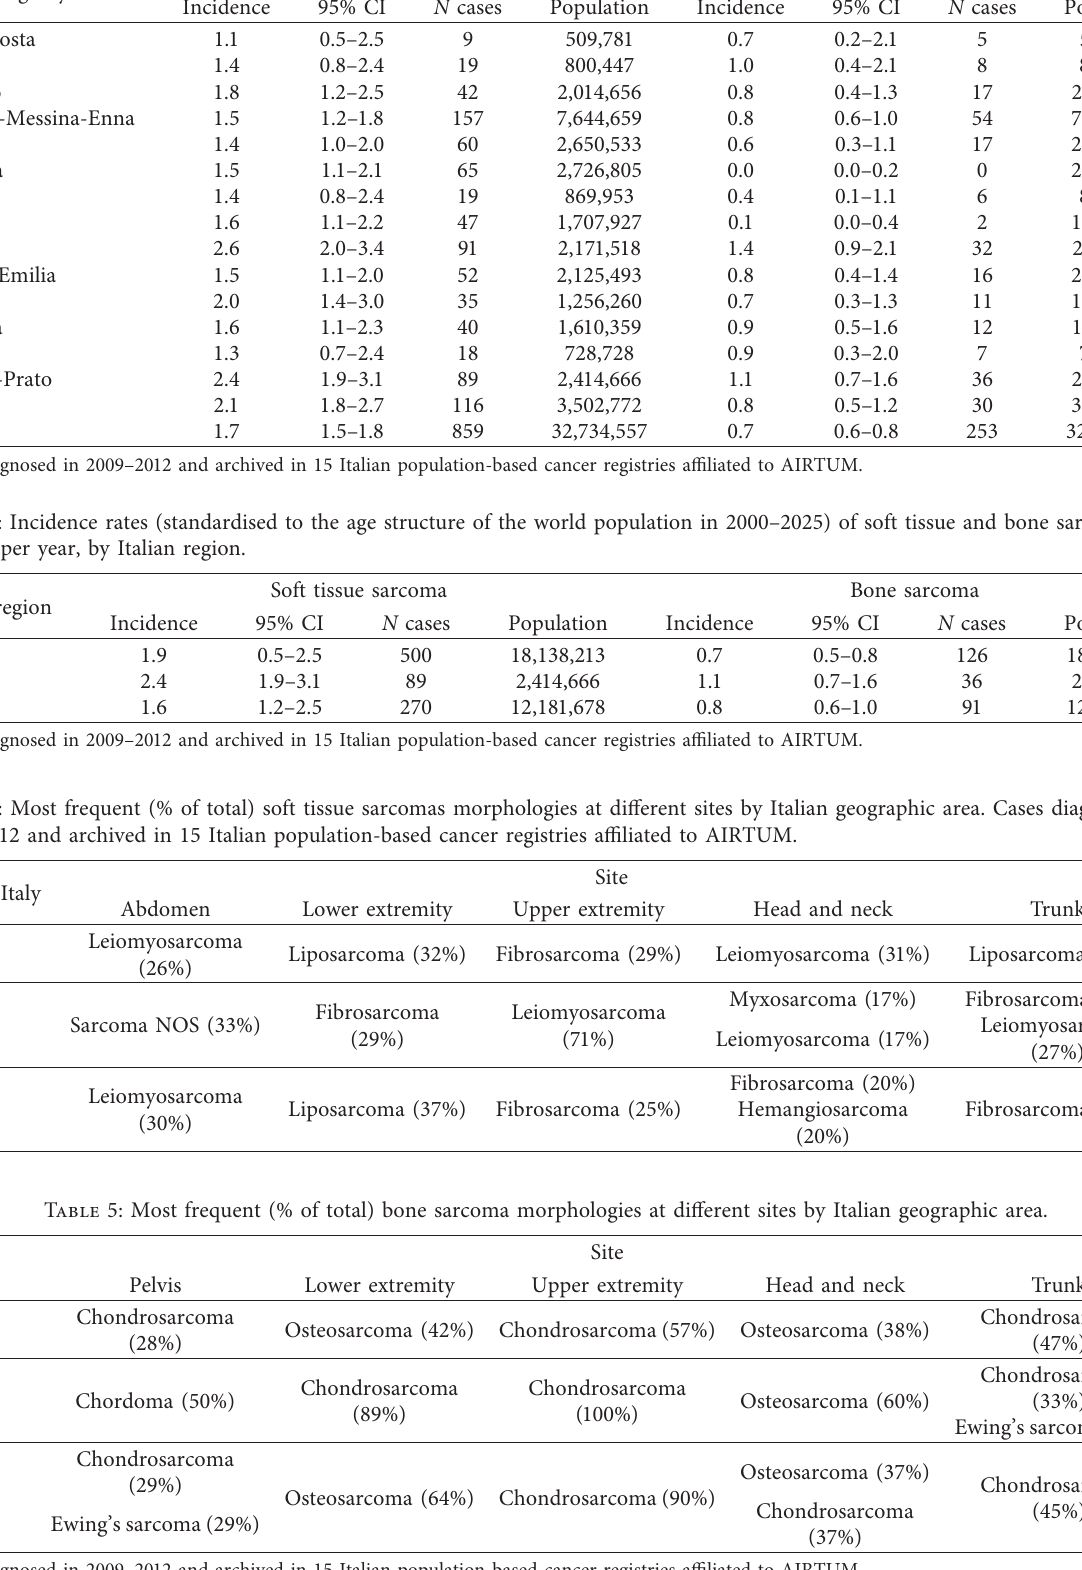
Cases diagnosed in 2009–2012 and archived in 15 Italian population-based cancer registries affiliated to AIRTUM.